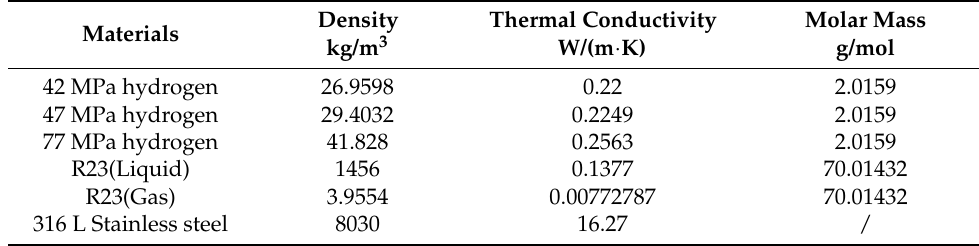
Table 2. Physical parameters of heat exchange fluid and heat exchanger